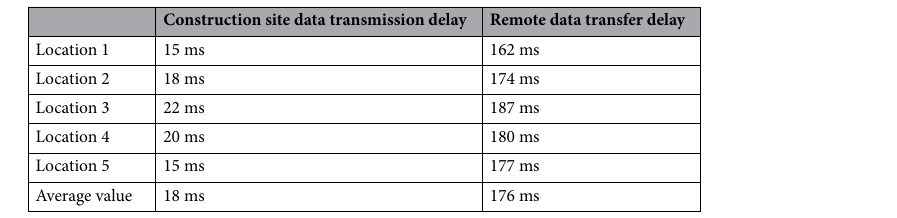
Table 3. Data transfer delay test